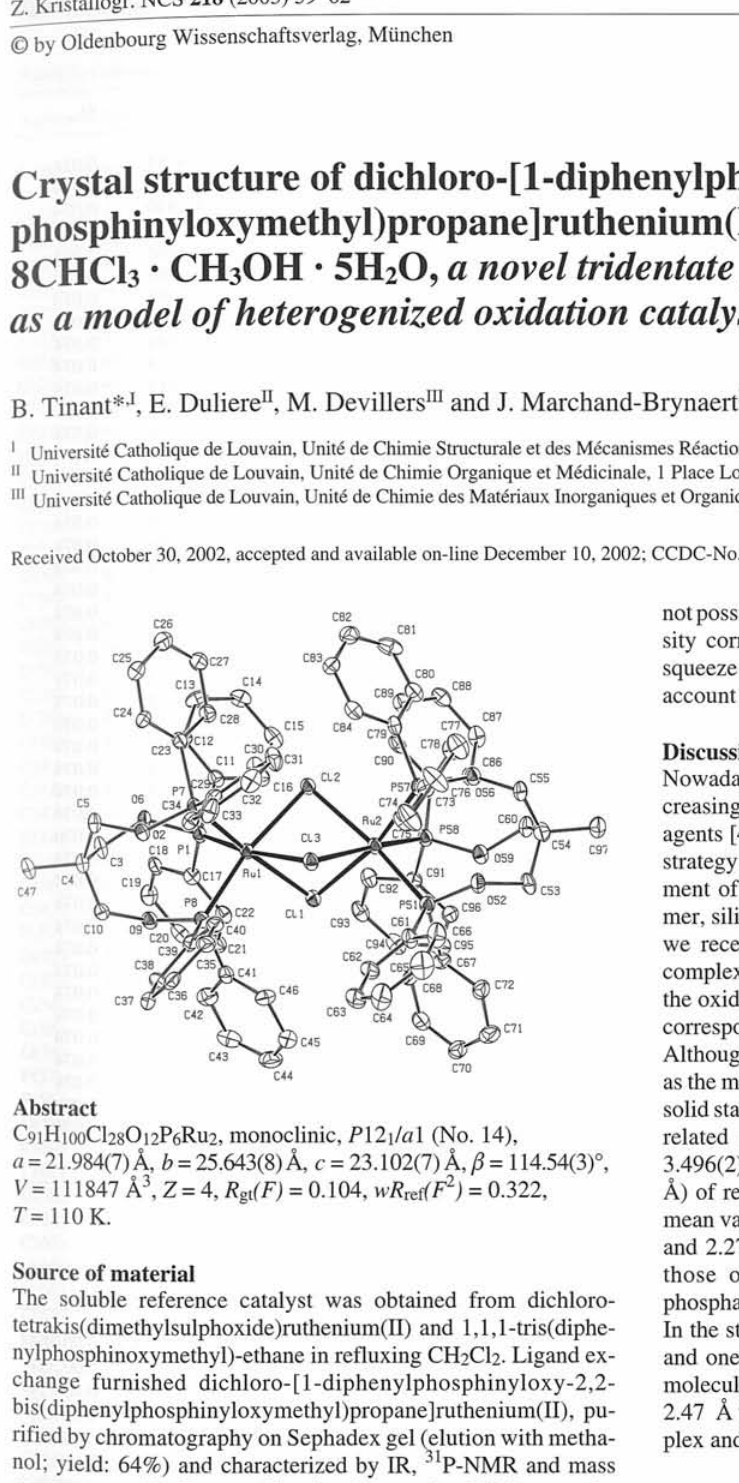
Table 1. Data collection and